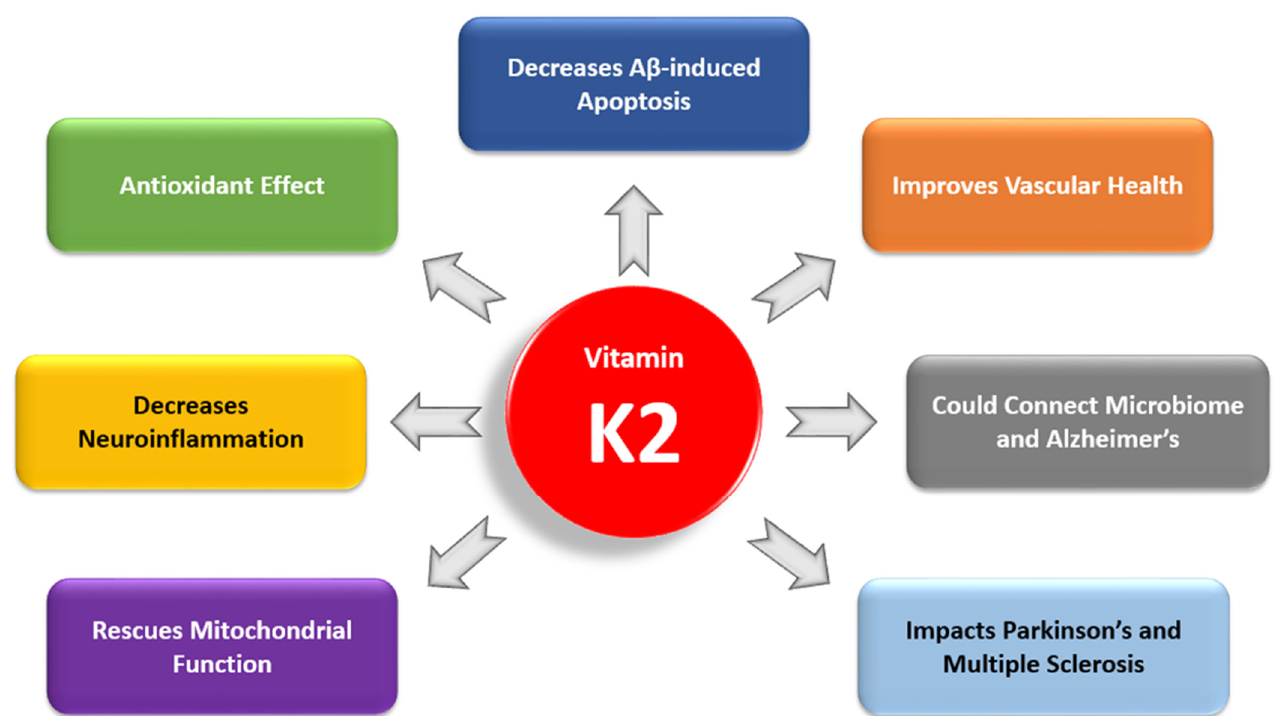
Figure 1. The roles of vitamin K2 in Alzheimer’s disease.